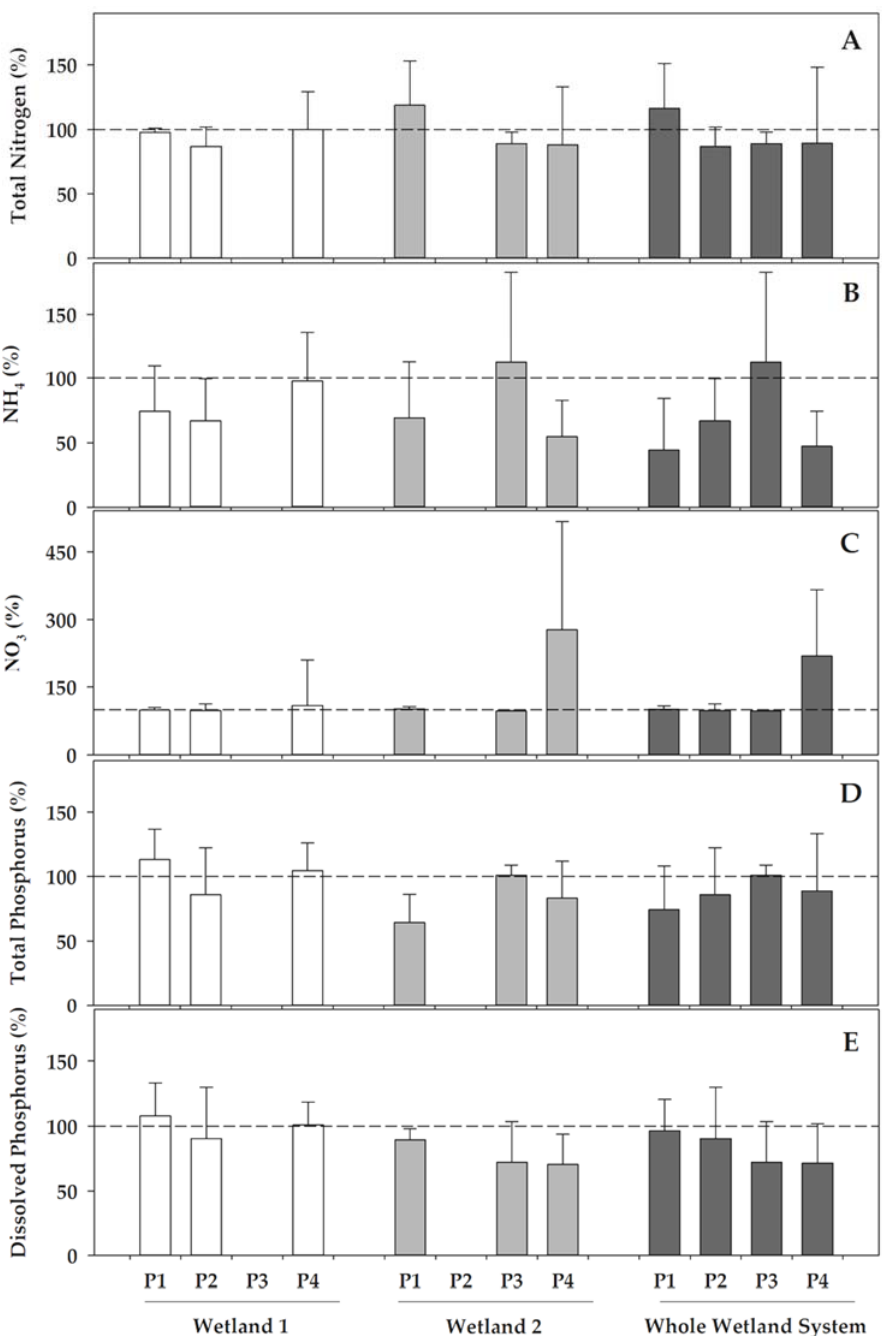
Figure 3. Percentage variations in different water features after passing Wetland 1 (left), Wetland 2 (centre), and the overall constructed wetland (right), compared to each of their inlets at each of the operational phases (P). The yield in the removal of pollutants was calculated as a percentage, comparing the value of each variable in the wetland inlet to that in the wetland outlet. ( A ) Total nitrogen, ( B ) ammonium, ( C ) nitrate, ( D ) total phosphorus, and ( E ) soluble (dissolved) reactive phosphorus. Data represent the mean (bar) and the standard deviation (whisker). Dashed line represents 100%, this is, equal concentration in the inlet as in the outlet. Wetland 1 was inoperative during phase 3, whereas Wetland 2 was inoperative during phase 2.